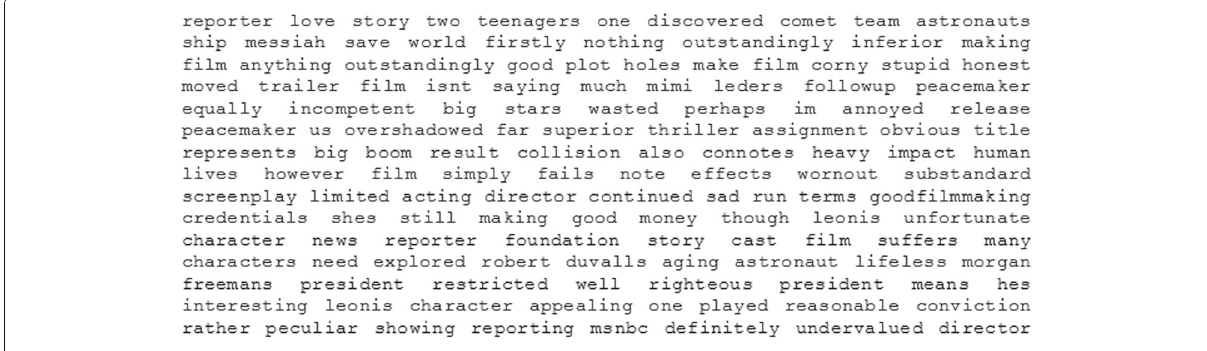
Fig. 4 A simple example of a test file from MR2004 [27] after